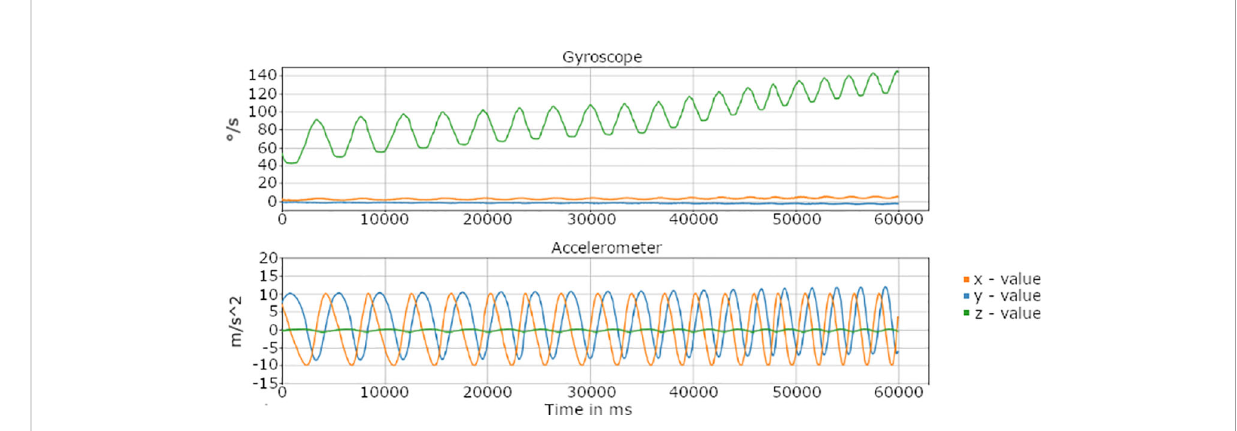
FIGURE 14 Visualized data for the starting process of the IMU mounted to a rotating lever. In the top diagram the gyroscope data are visualized. In the bottom diagram the accelerometer values are